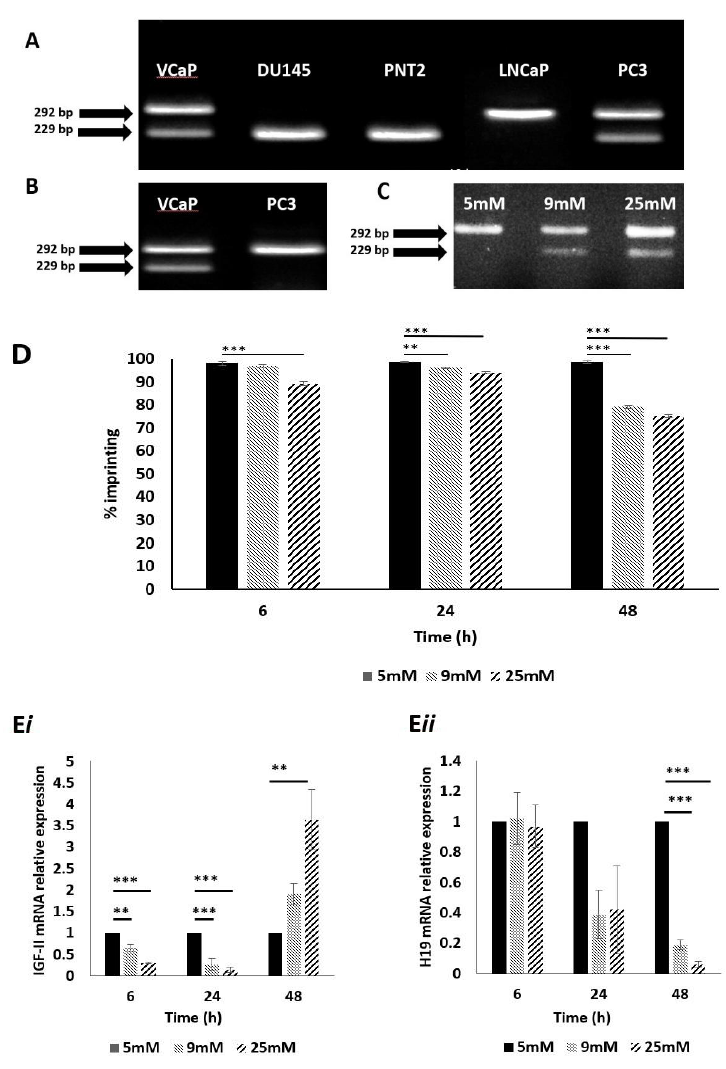
Figure 1. Genotyping, IGF-II allelic expression and imprinting behaviour after treatment with glucose, in prostate cancer cell lines using APA1 RFLP, PIE and qPCR analyses. ( A ) Gel image depicting genotype results of cell lines VcaP, DU145, PNT2, LNCaP and PC3. VcaP and PC3 showed two bands, sized 292- and 229 bp. This meant that these cells were heterozygous for the SNP at rs680 and, therefore, informative. ( n = 3). ( B ) Gel image depicting IGF-II allelic expression. The VcaP cell line showed two bands, sized 292 and 229 bp, signifying bi-allelic expression and, therefore, loss of imprinting of IGF-II. The PC3 cell line showed a single band sized 292 bp, indicating mono-allelic expression of IGF-II and, therefore, a retention of imprinting status. ( n = 3). ( C ) Gel image depicting the effects of varied glucose concentration on IGF-II allelic expression in the PC3 cell line after 48 h. Cells cultured in 9- and 25 mM glucose showed two bands sized 229 and 292 bp, indicating a change from mono- to biallelic IGF-II expression and, therefore, loss of imprinting. ( n = 3). ( D ) Imprinting percentage change of PC3 cells after exposure to glucose for 6, 24 and 48 h. After 6 h, cells cultured in 25 mM glucose showed a highly significant ( p < 0.001) decrease in imprinting percentage compared to those cultured in 5mM glucose. After 24 h, cells cultured in 9 and 25 mM glucose showed significant decreases in imprinting percentage ( p = 0.01 and p < 0.001, respectively), when compared to those cultured in 5 mM glucose. After 48 h, cells cultured in 9 and 25 mM glucose showed highly significant decreases in imprinting percentage ( p < 0.001 and <0.001 respectively), when compared to those cultured in 5 mM glucose. ( n = 3). I IGF-II and H19 mRNA relative expression in the PC3 cell line, after exposure to increased glucose levels; a significant increase in IGF-II mRNA expression ( i ) was observed after 6, 24 and 48 h in 9 and 25 mM glucose media. A significant decrease in H19 mRNA expression ( ii ) was observed after 48h in 9- and 25 mM glucose media. ** p = 0.01 and *** p <